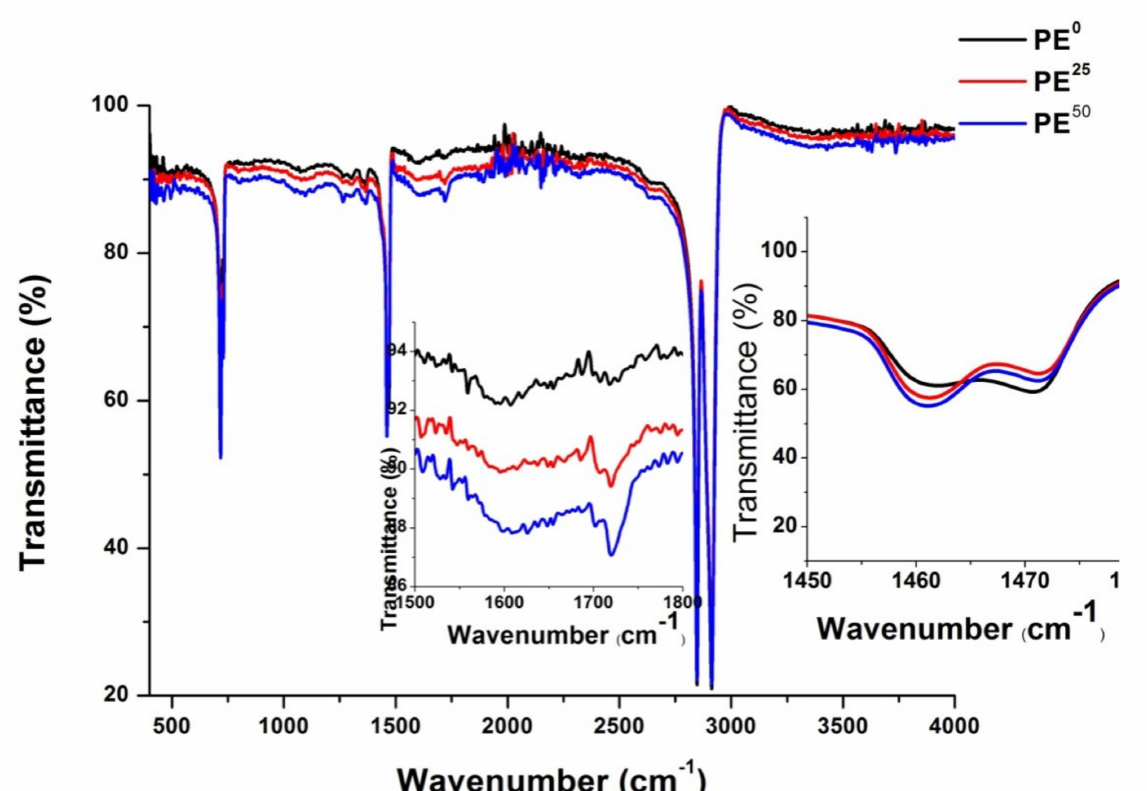
Figure 1. FTIR spectra of unirradiated and irradiated pristine UHMWPE. The specific bands of interest that undergo significant alterations after the incorporation of SP and/or irradiation are given in Table 3